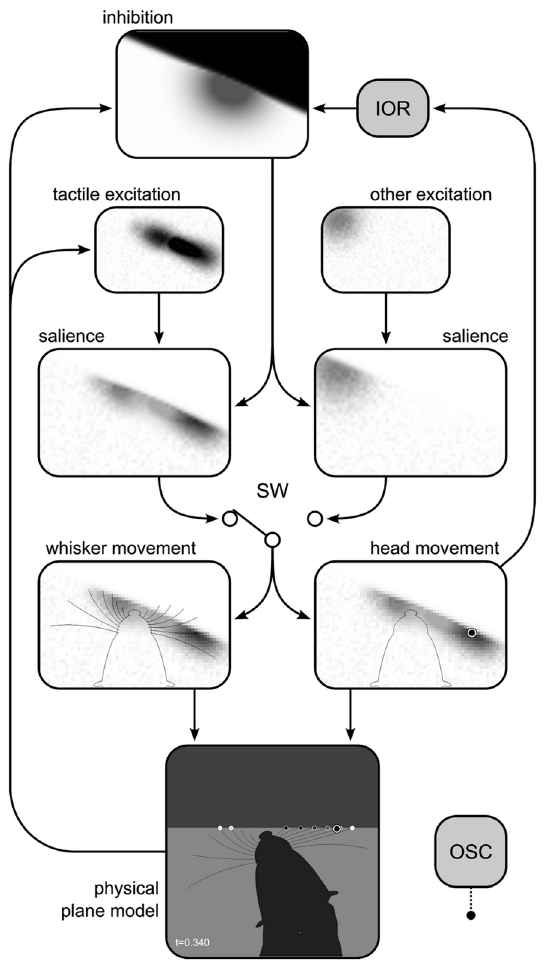
Figure 3. Implementation of the model. Boxes indicate compo- nents, solid arrows indicate causal influences. Extends/modifies model of Figure 2 with implementation-specific components: attended region made explicit as salience map(s); ‘other signals’ implemented as an endogenous stochastic source; inhibition, including a contribution from inhibition-of-return (IOR) system; oscillator (OSC); ‘physical plane model’ simulates mechanics. Separate salience channels are maintained for tactile and ‘other’ signals and selected at switch (SW). Data snapshot . Within the boxes is displayed a data snapshot from a point of maximum protraction during a whisk against a vertical surface. Physical plane model in world-centric coordinates includes head, whiskers and obstacle surfaces; whisker contacts are shown as dots (darker dots indicate stronger bending) and current target of foveation as a ‘target’ icon. Tactile and ‘other’ signals are mapped into head-centric excitation maps which drive salience maps (darker areas represent higher salience; pattern corresponding to wall can be seen in tactile salience map). Activity in salience map regions inside obstacles as well as in previously- visited regions (IOR, see text) is inhibited. Tactile salience channel is selected at SW owing to higher peak salience than ‘other’ channel. Whisker movement panel shows maximum protraction computed to roughly achieve MIMC with respect to attended region. Head movement panel shows current target of foveation (target icon) at peak of salience map. Video S4 shows the operation of the implementation during a trial including this snapshot (which was taken at t=0.340).